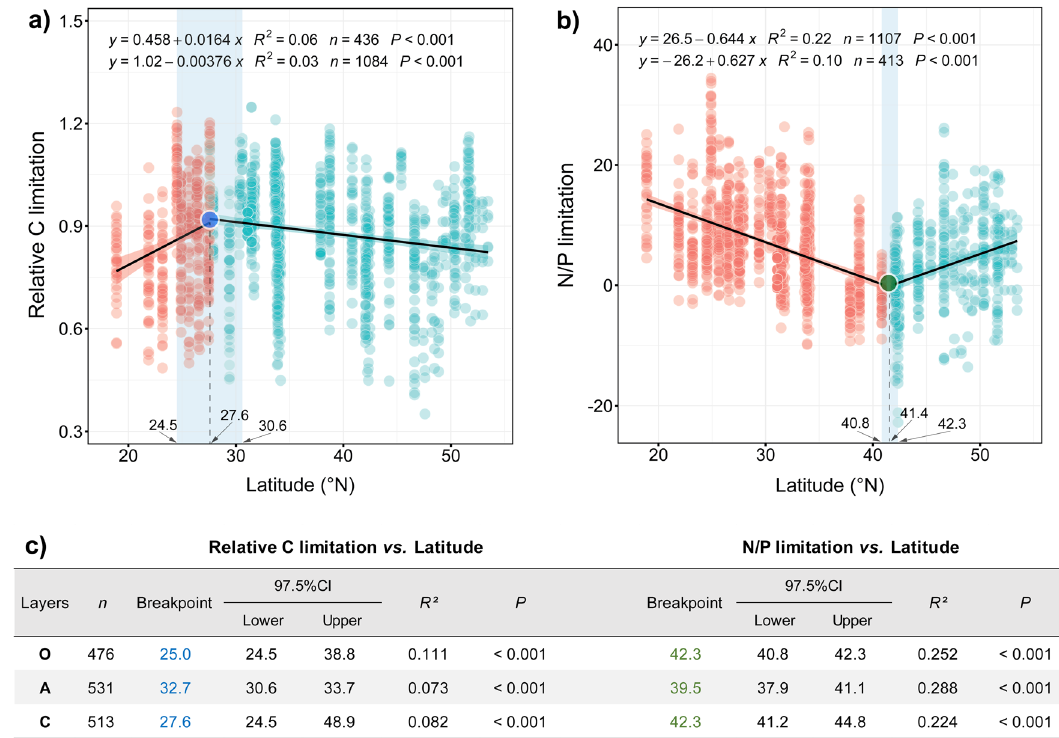
Fig. 2 The latitudinal patterns and breakpoint estimation for soil microbial metabolic limitations across Chinese forests. a , b The latitudinal breakpoints for microbial metabolic limitations were estimated using piecewise regression analyses, and relationships of relative C limitation ( a ) or N/P limitation ( b ) with latitude in Chinese forests were identi fi ed using generalized linear models. The shaded circles indicate breakpoint latitudes, while shaded areas are the 97.5% con fi dence intervals of the breakpoints. Solid black lines indicate model fi ts between relative C limitation or N/P limitation and latitude. c Estimated latitudinal breakpoints for soil microbial metabolic limitations among different soil layers across Chinese